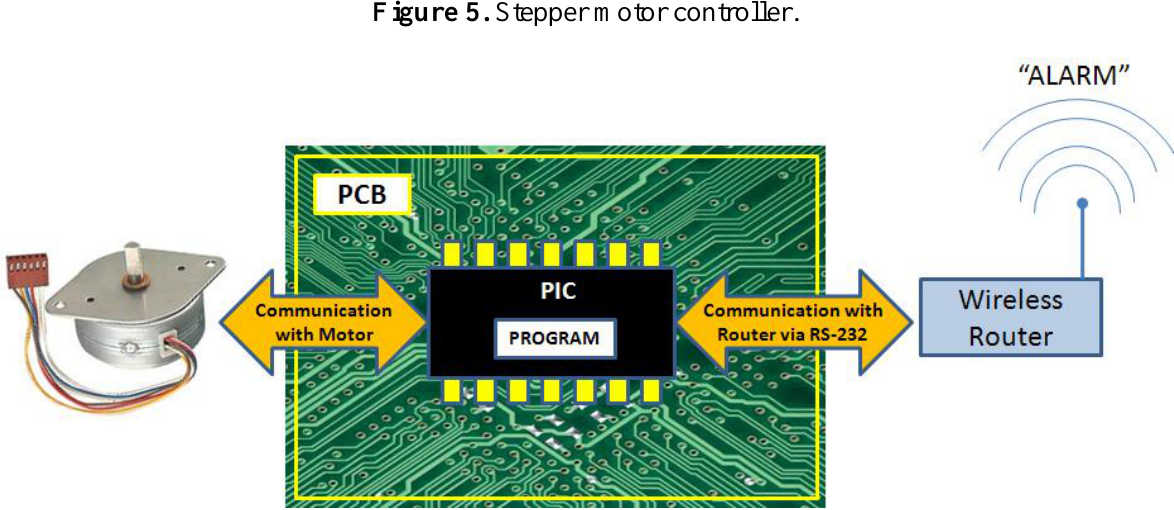
Figure 5. Stepper motor controller.